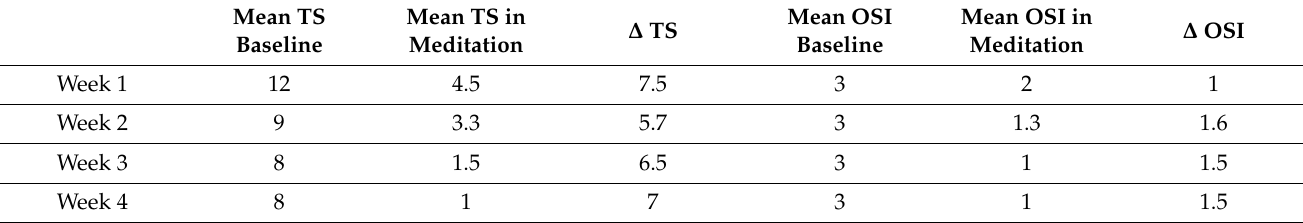
Figure 1. Baseline vs. in-meditation AIMS Total Score (TS) and Overall Severity Index (OSI). AIMS: Abnormal Involuntary Movement Scale. TS: Total score (equal the sum of the AIMS scoring given at the items from 1 to 7). OSI: Overall Severity index (equal the AIMS scoring given at the item 8). Table 1. AIMS scoring divided per intervention weeks.